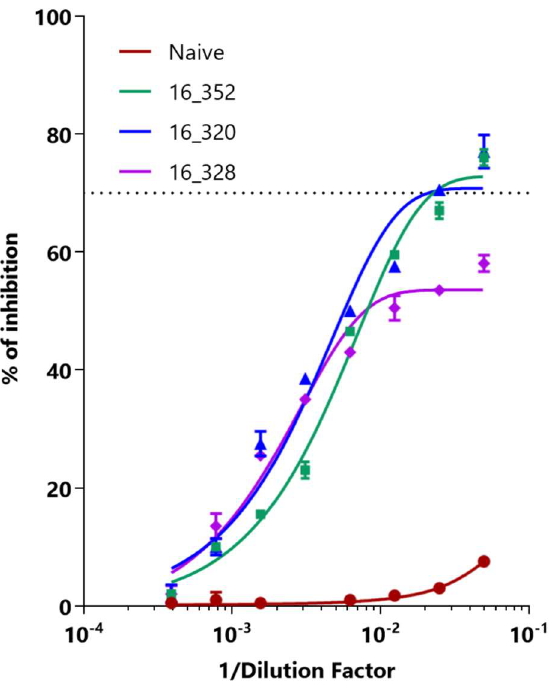
Figure 4. Selection of sample working dilution from standard curves . Dilutions from 1/20 to 1/2560 of standards as well as a pool of naïve sera (circles) were analyzed. Measurements were made in duplicates. 16_352 (squares), 16_320 (diamonds) and 16_328 correspond to WHO International Standards.